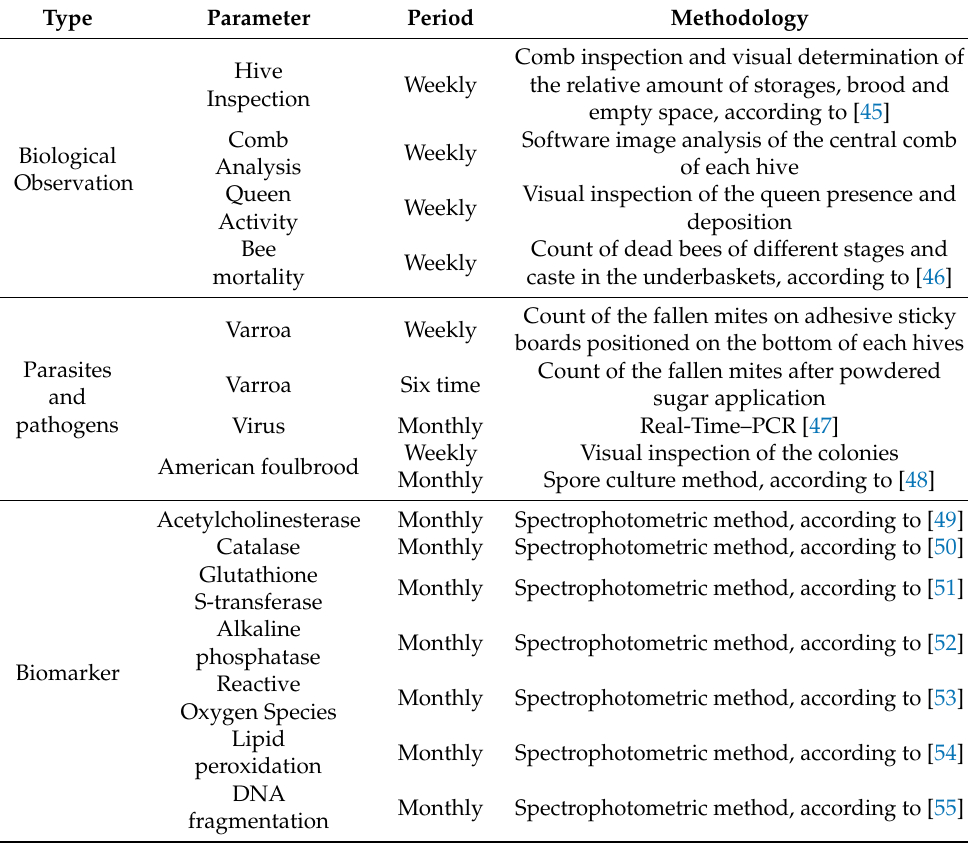
Table 1. Health status parameters considered in the trial from April 2017 until April